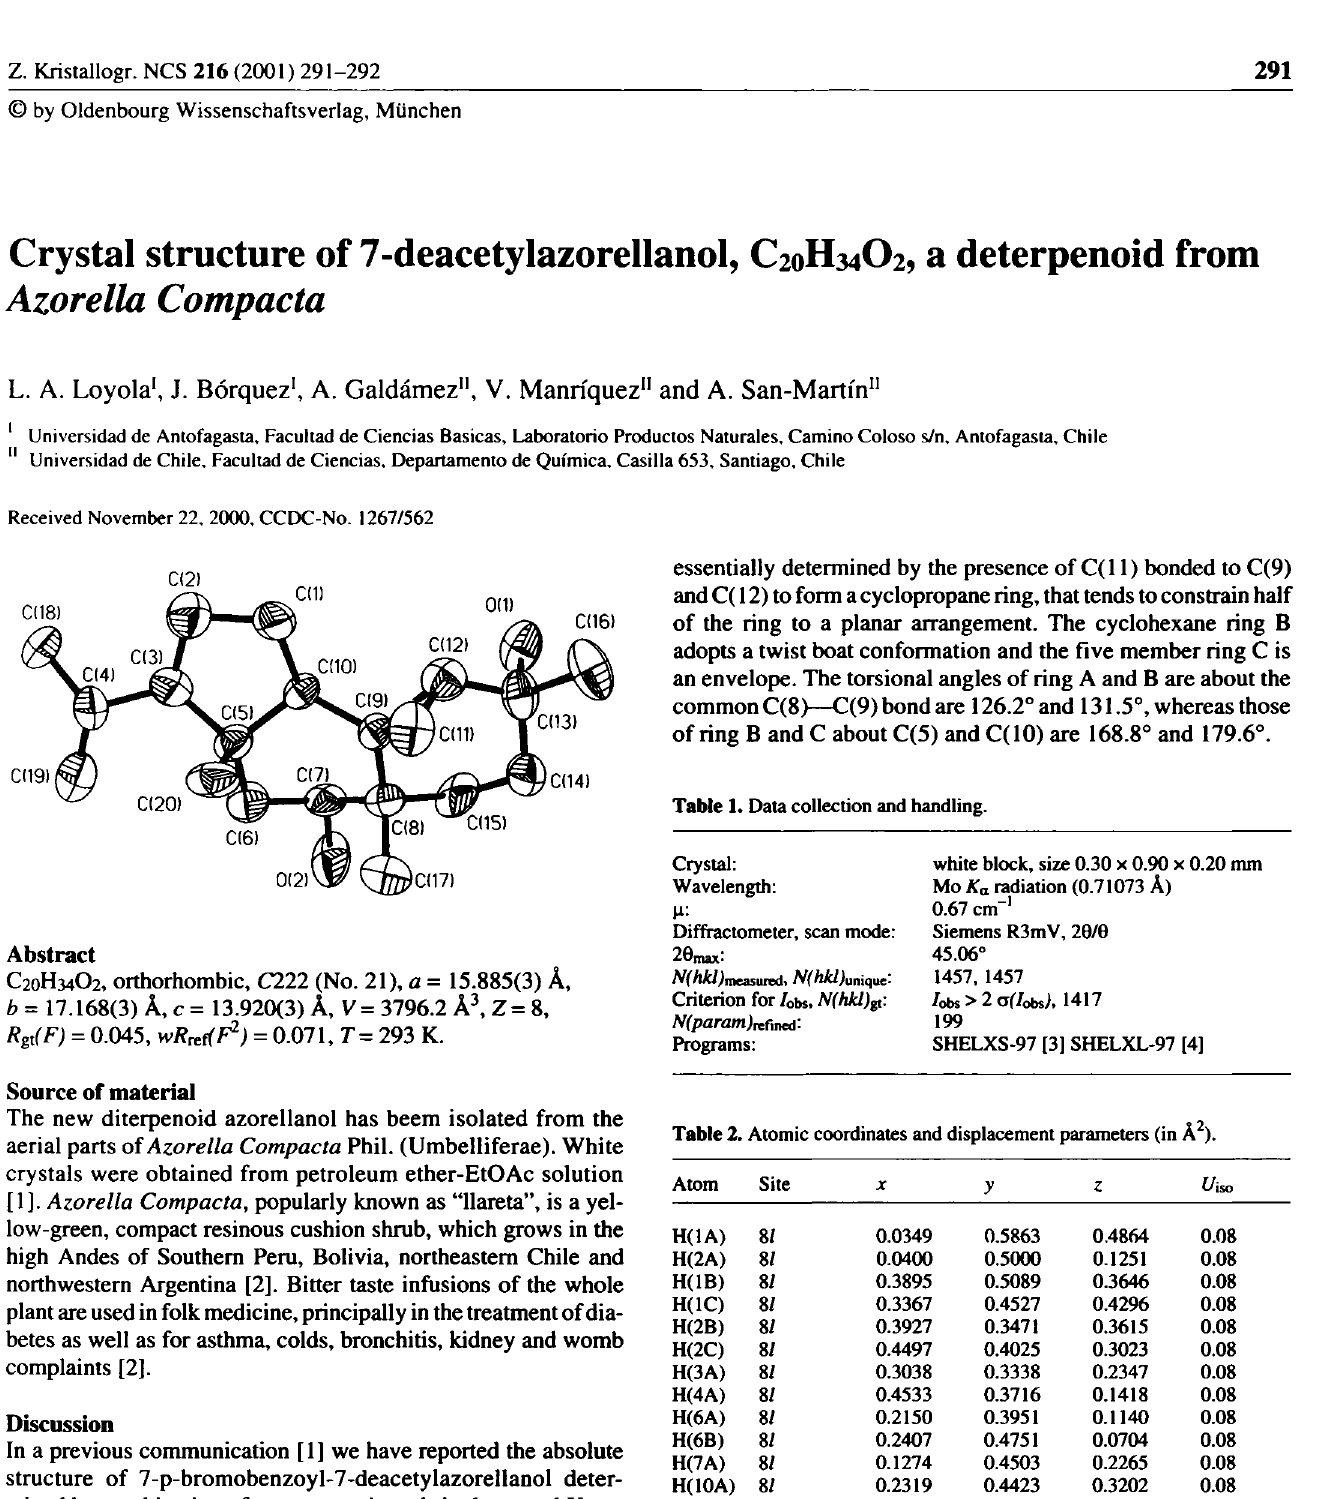
Table 2. Atomic coordinates and displacement parameters (in Ä 2